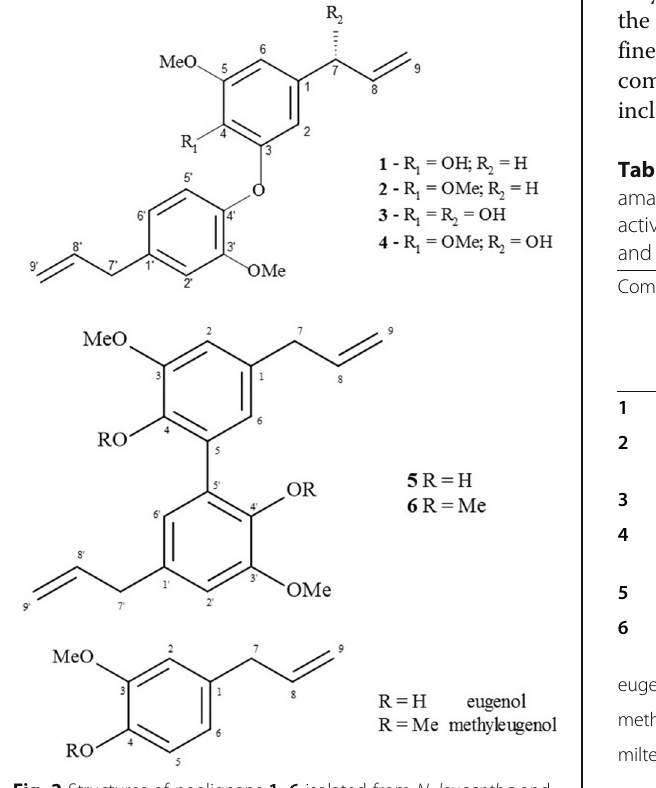
Fig. 2 Structures of neolignans 1 – 6 isolated from N. leucantha and monomers eugenol and methyleugenol